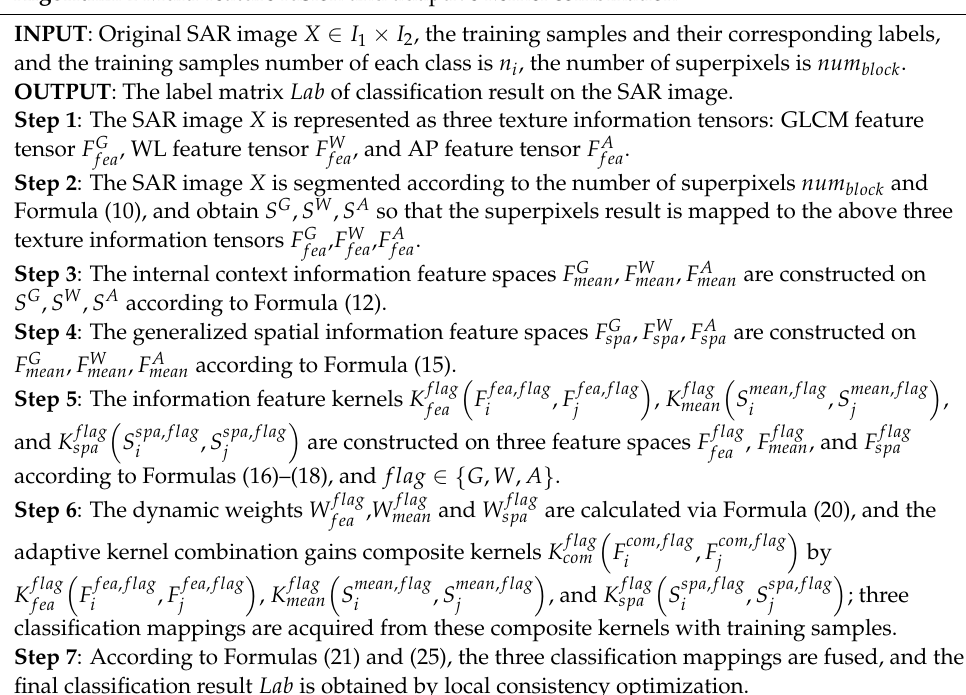
Algorithm 1 Multi-feature fusion and adaptive kernel